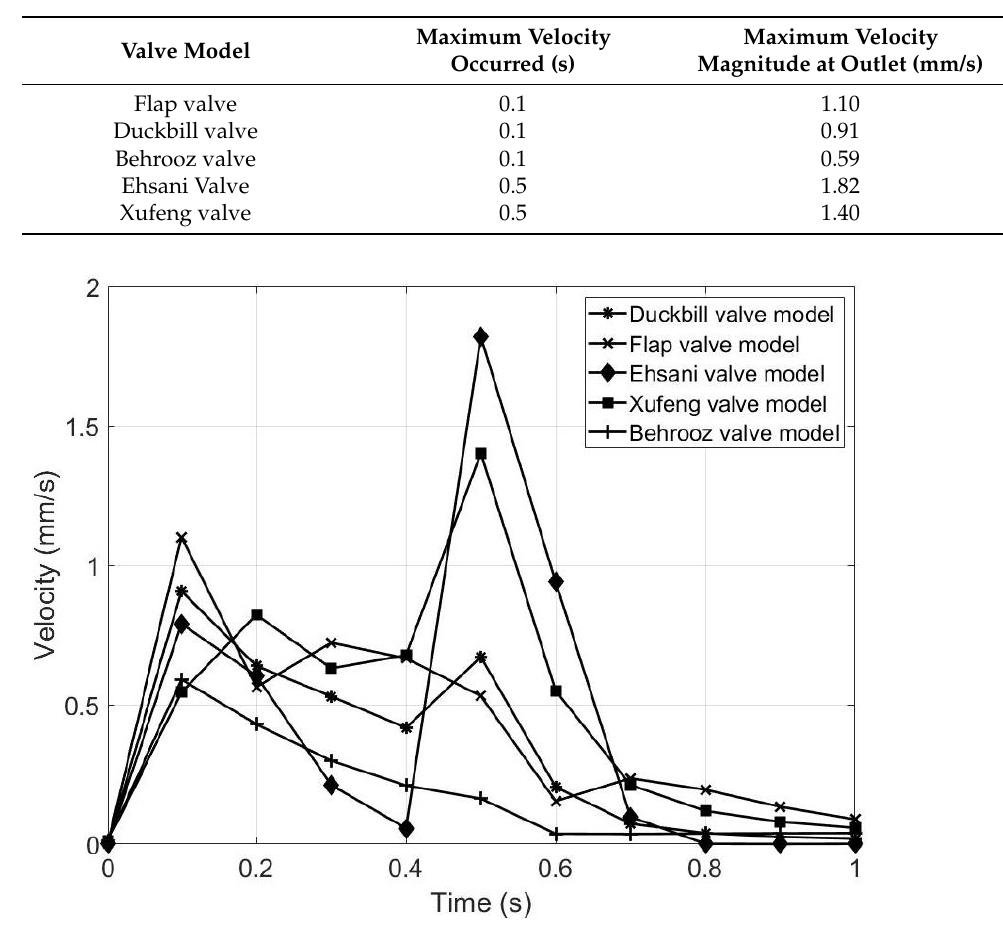
Figure 12. Graphical representation of velocity magnitude at the outlet of the five valve models. Table 6. Maximum velocity magnitude for all five valve models.